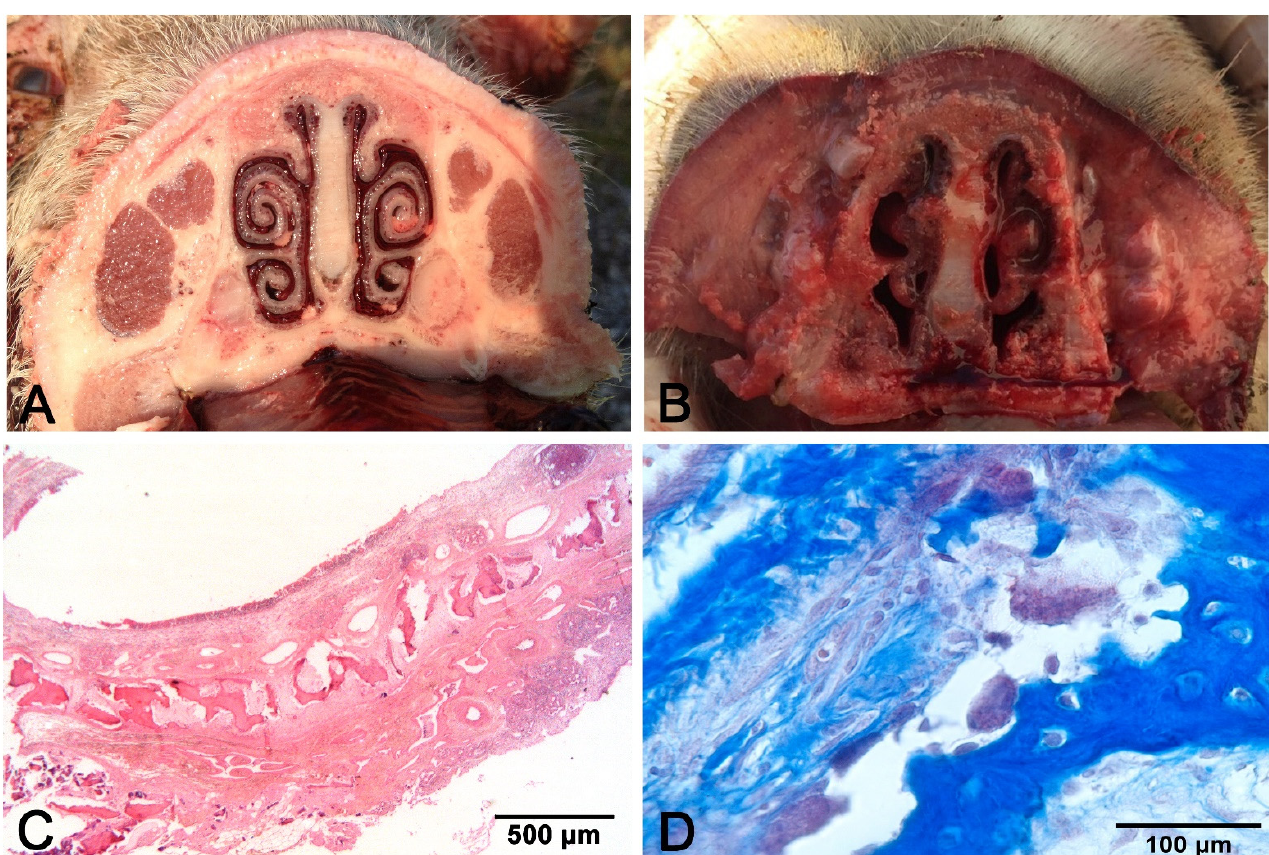
Figure 1. Progressive atrophic rhinitis (PAR): ( A ) control non-affected; ( B ) bilateral symmetric complete atrophy of turbinates; ( C ) discontinuous mural bone in the turbinate; ( D ) hyperplasia of osteoclasts facing bone trabeculae. ( C ) hematoxylin–eosin (H–E) stain. ( D ): Masson’s trichrome stain.